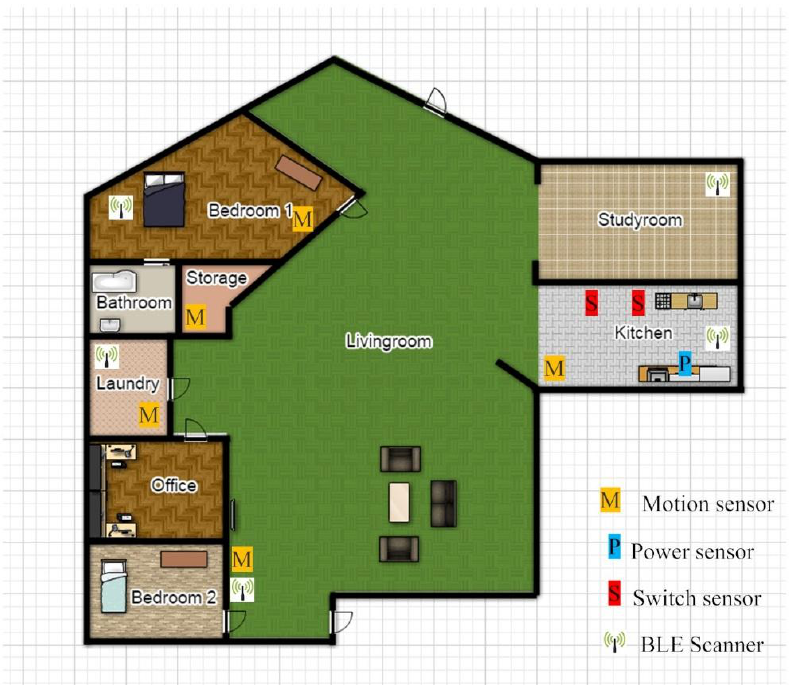
Figure 10. Multi-resident smart home architecture.